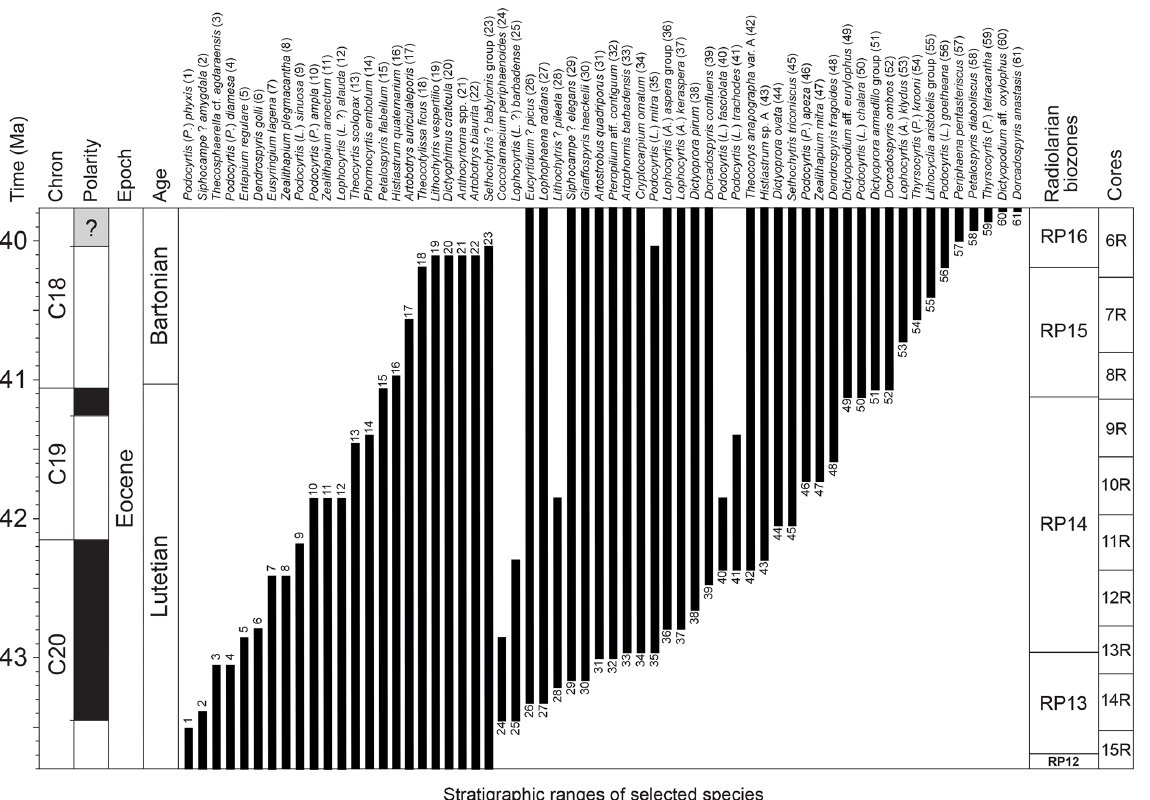
Figure 2. Range chart of 61 selected radiolarian species from the middle Eocene of ODP hole 1260A. Geomagnetic timescale after calibra- tion of Suganuma and Ogg